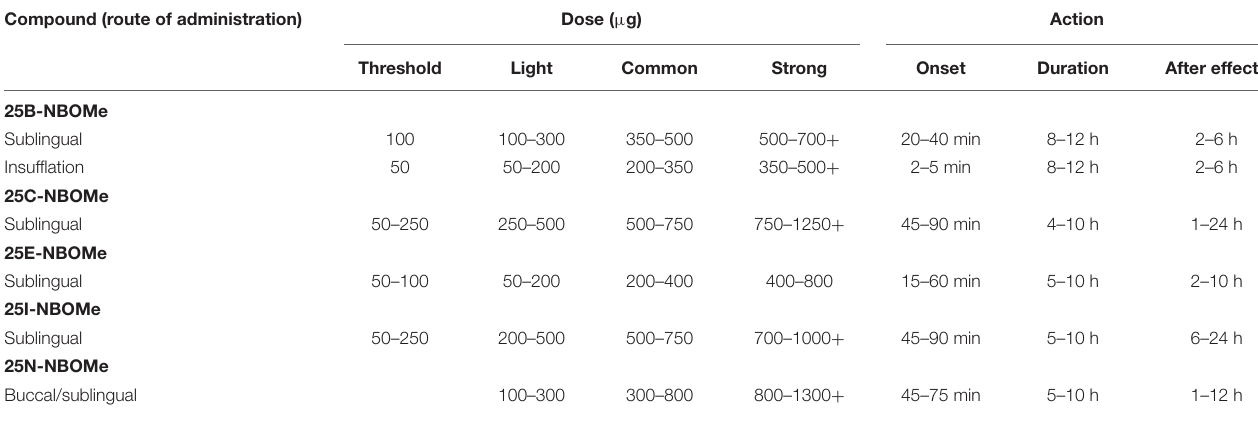
TABLE 1 | Doses and duration of action of NBOMe compounds (TripSit a, b, c, d,